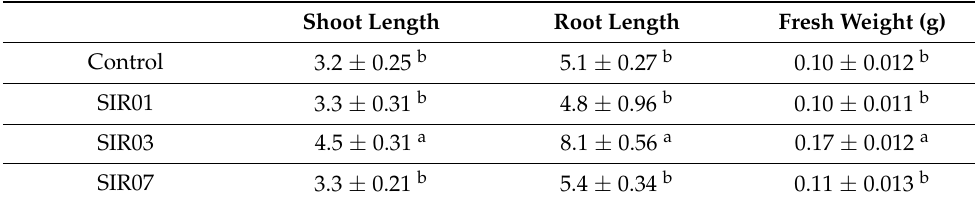
Table 2. Bioassay for growth promotion activity of three selected strains (SIR01, SIR03, and SIR07) in Waito-C rice.